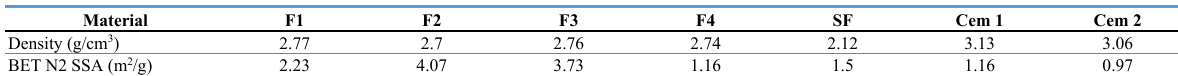
Table 4. Physical characterization of fines.